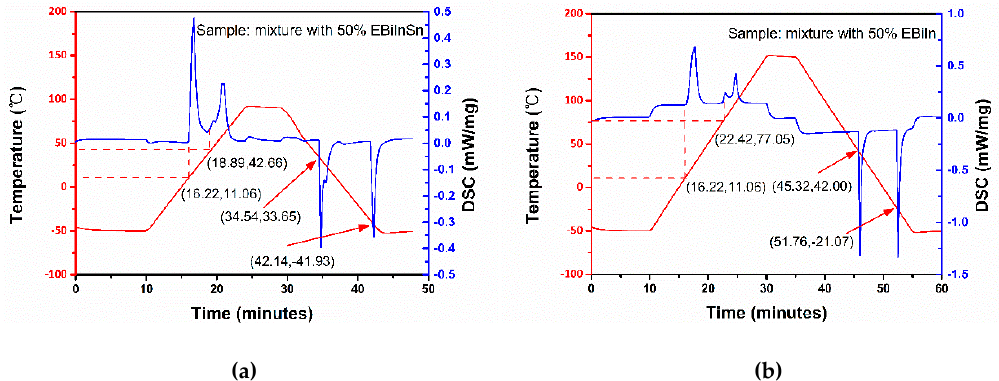
Figure 4. ( a ) Differential scanning calorimetry (DSC) phase diagram of mixture with 50% mass ratio of EBiInSn. ( b ) DSC phase diagram of mixture with 50% mass ratio of EBiIn.